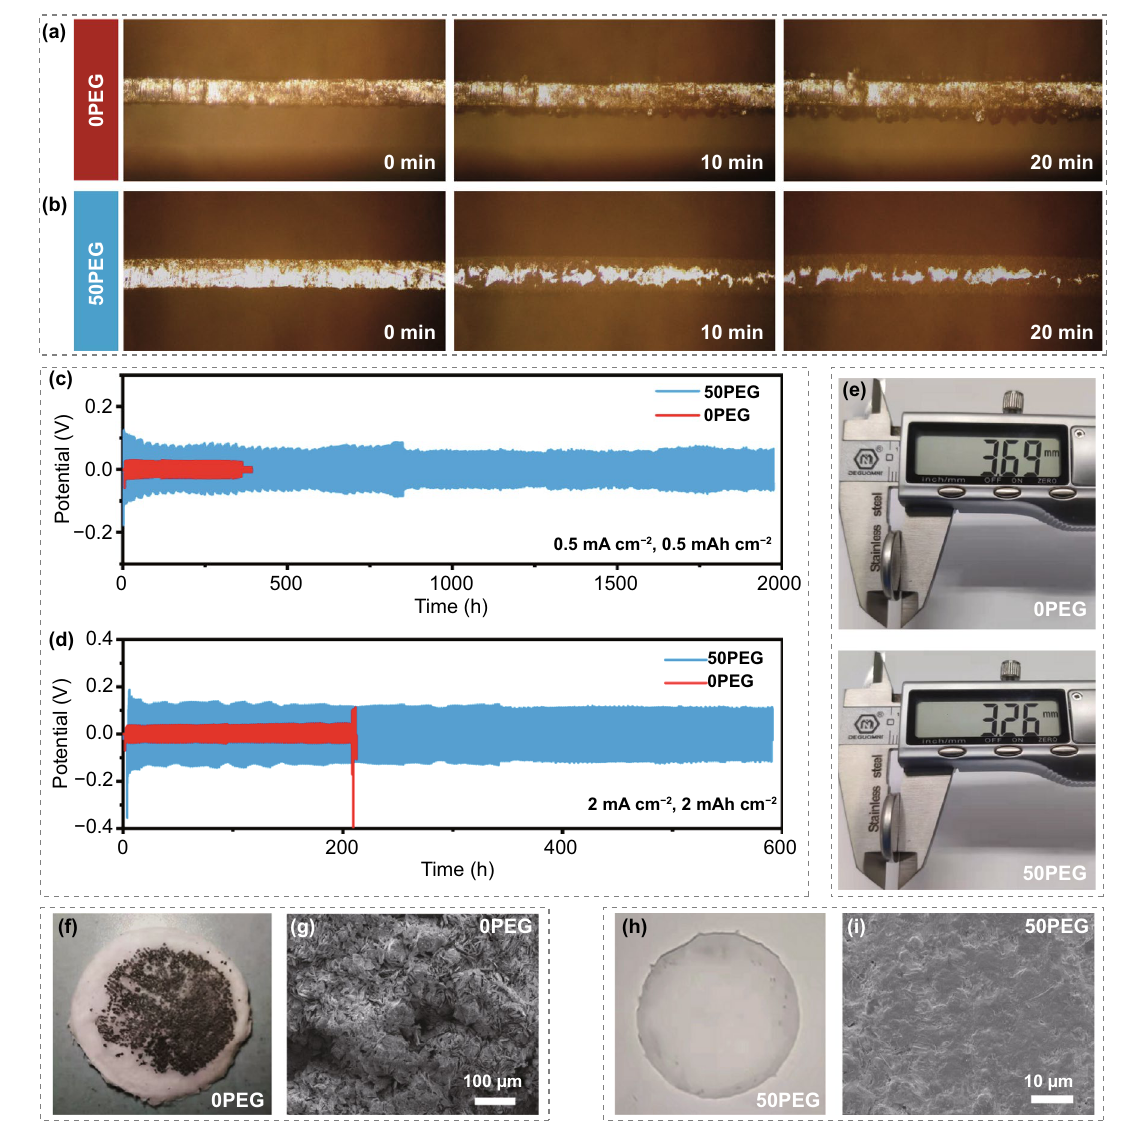
Fig. 7 In-situ optical observation of Zn deposition in a 0PEG and b 50PEG electrolyte at the current density of 10 mA cm −2 . The cyclic stabil- ity of Zn||Zn symmetric cell at the testing conditions of c 0.5 mA cm −2 , 0.5 mAh cm −2 and d 2 mA cm −2 , 2 mAh cm −2 , respectively. e The thick- ness of Zn||Zn symmetric cell after cycling for 200 h at 2 mA cm −2 and 2 mAh cm −2 , and the digital images of corresponding GF separator and FESEM images of corresponding Zn metal anodes in ( f , g ) 0PEG and ( h , i ) 50PEG